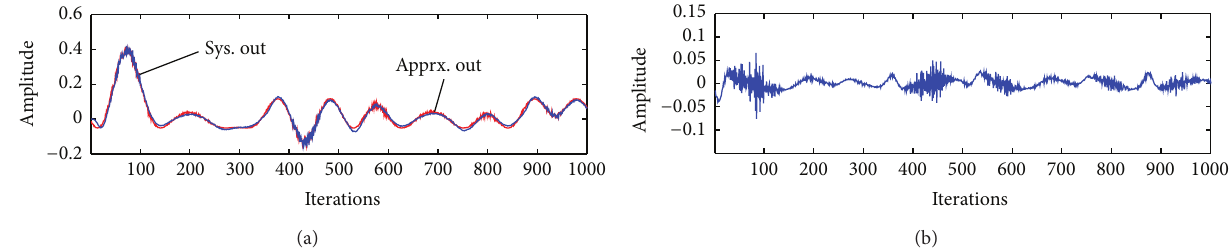
Figure 8: The simulation result with D-LMS algorithm. (a) Process of identification. (b) Error of identification.